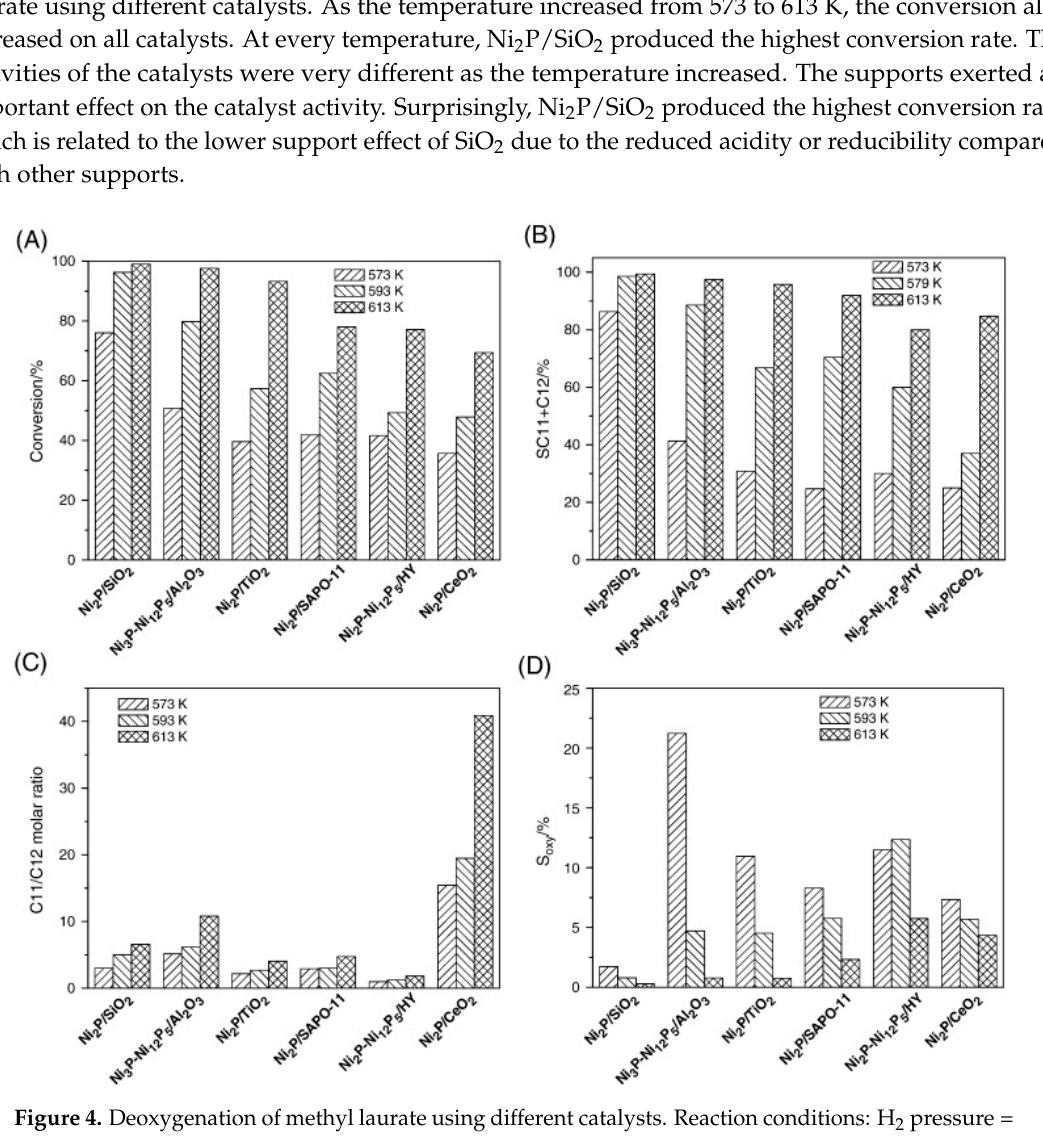
Figure 4. Deoxygenation of methyl laurate using different catalysts. Reaction conditions: H 2 pressure = 2.0 MPa, WHSV = 10 h, H 2 /methyl laurate molar ratio = 50. (Reproduced with permission from Elsevier Science Publishers [85]).